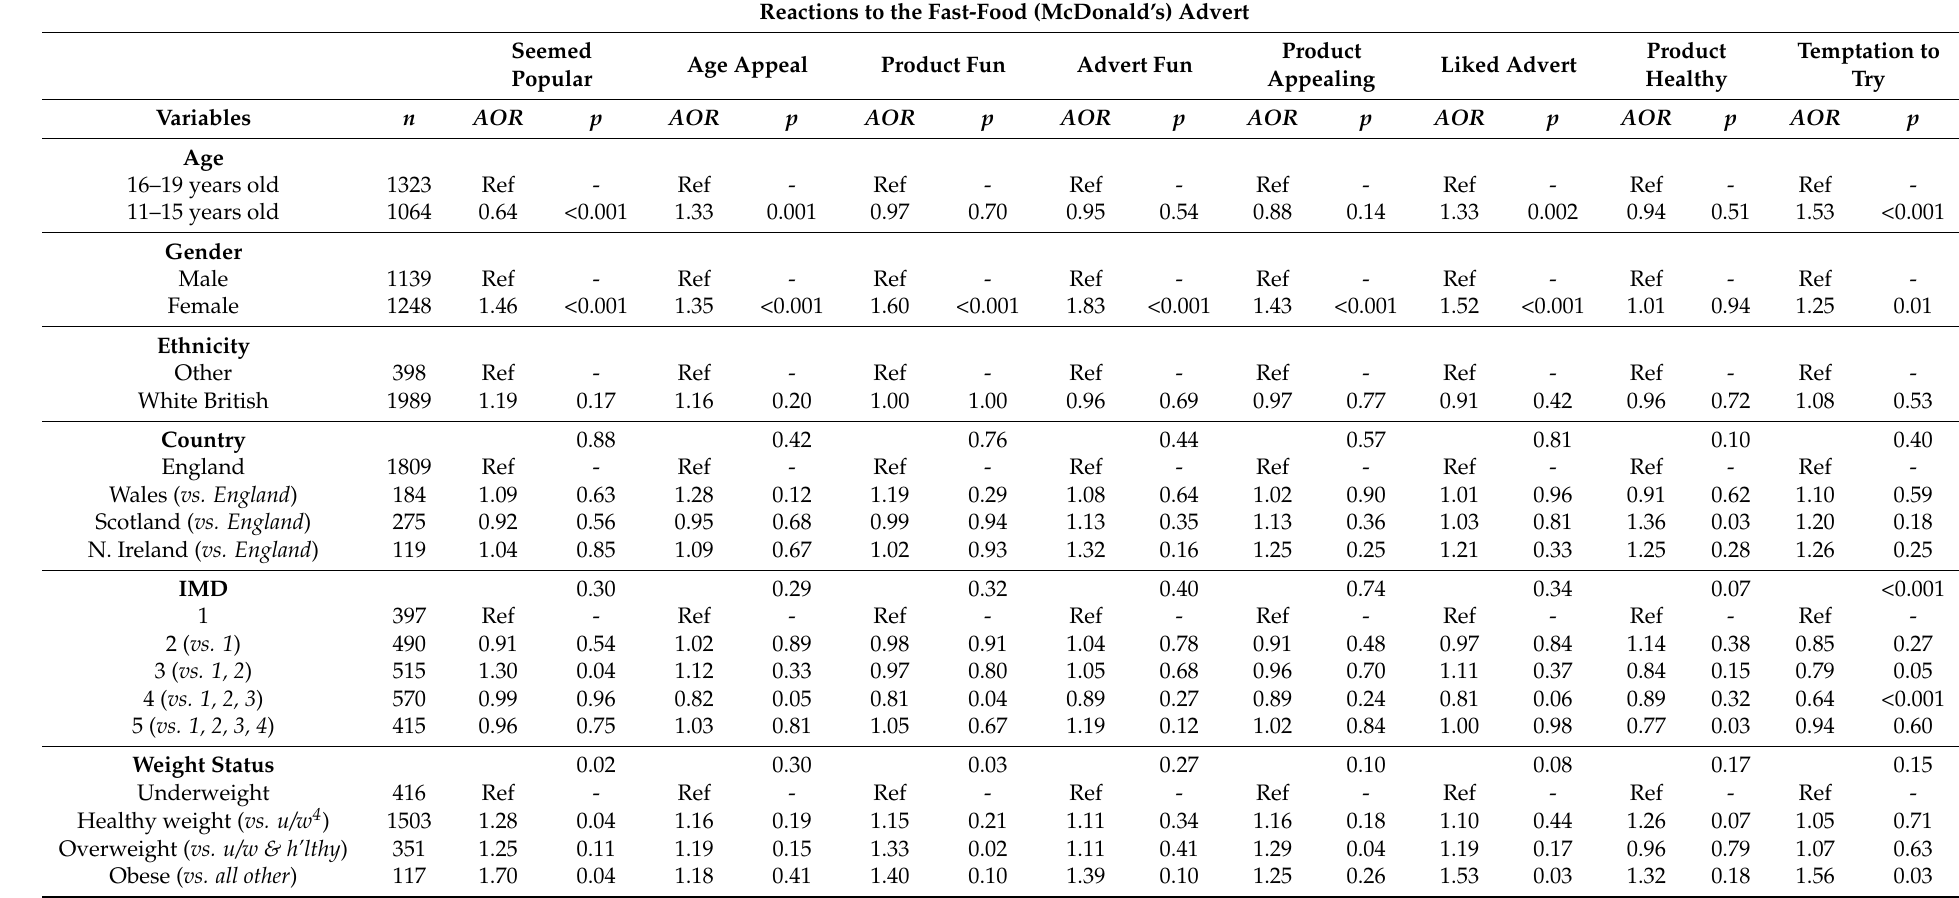
Table 3. Reactions to the fast-food advert and associations with demography and the BMI